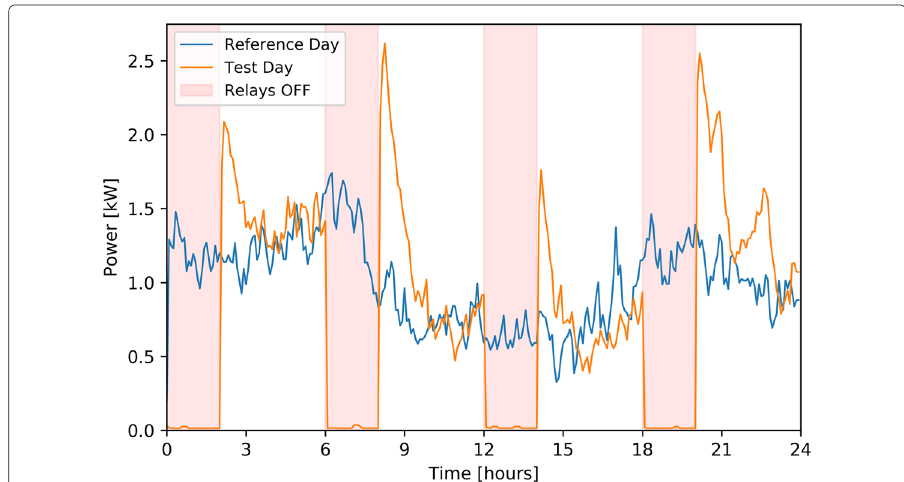
Fig. 10 Average heating appliances power of 73 households during a reference day and during a day when regular 2 hours cuts of the appliances were implemented. It can be noted that the rebounds are bigger than with one hour cuts and that the induced oscillations are also more